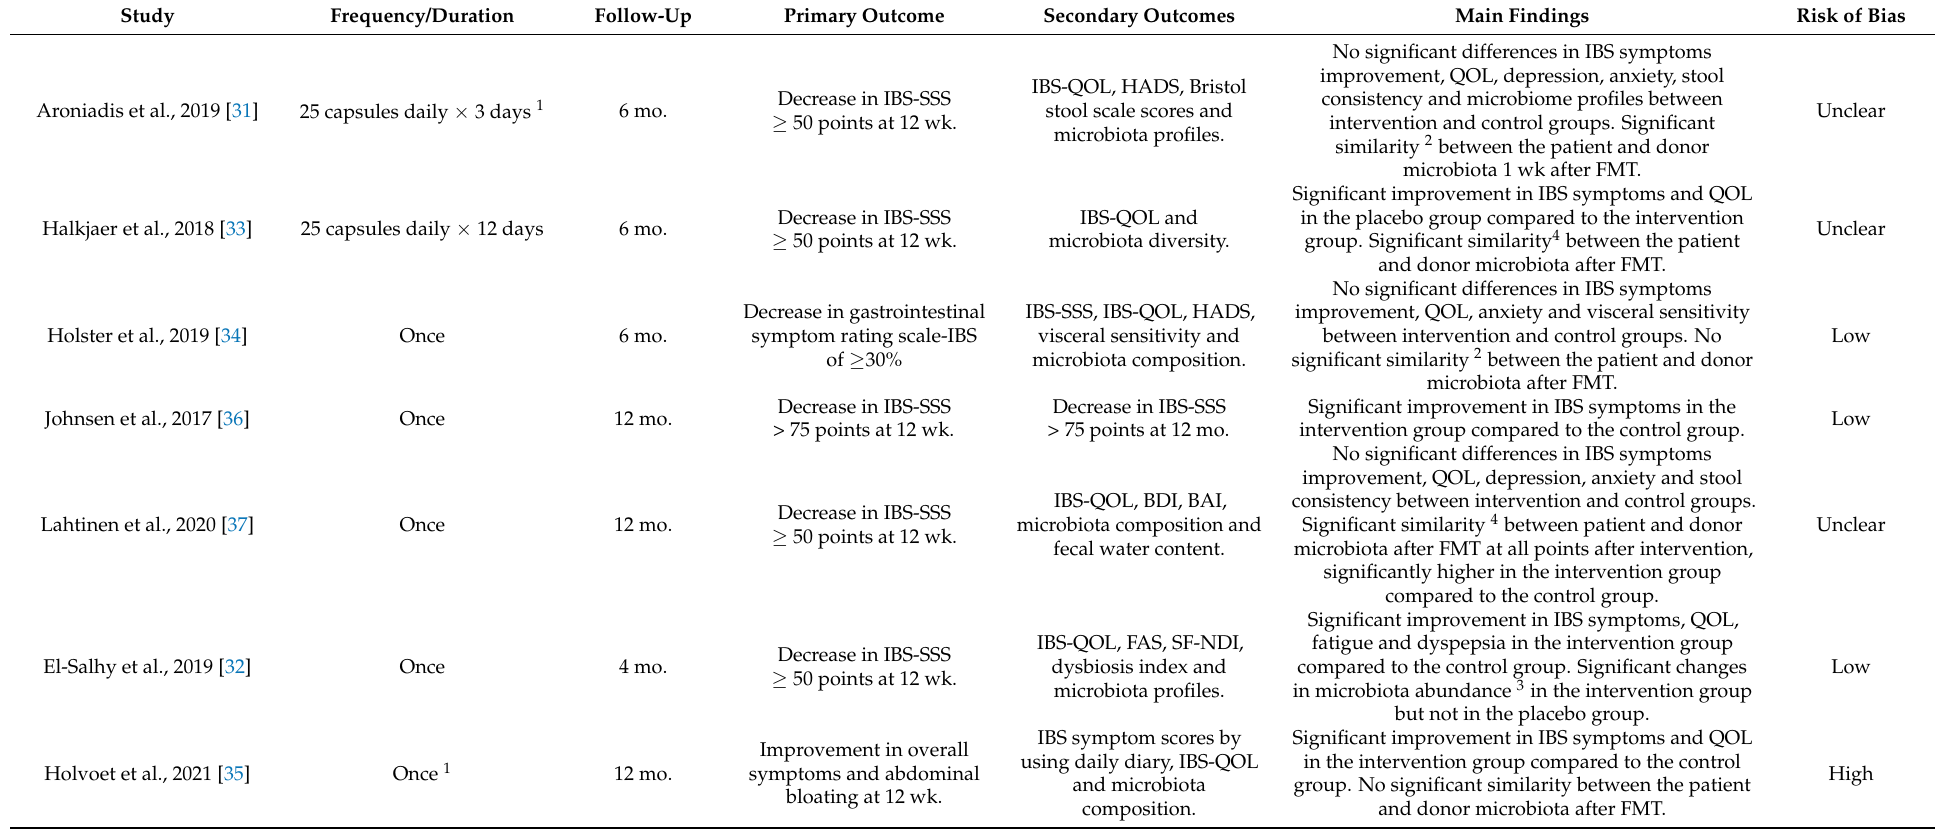
Table 2. Characteristics of the studies included in the systematic